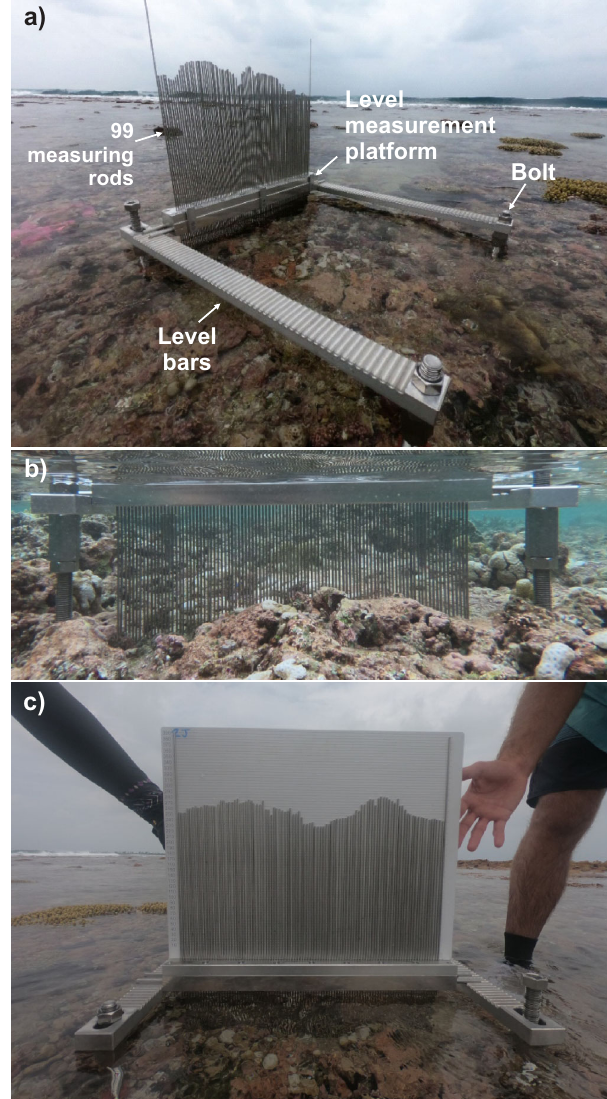
Fig. 5 Coral Reef Accretion Frame (CRAF) setup and measurement system. a Components of the CRAF at Site 2 on the Keleihutta outer reef fl at. b Below waterline view of measurement rods de fi ning the reef fl at topography. c Image of graduated back board used to take in situ images of the reef surface topography beneath the horizontal reference